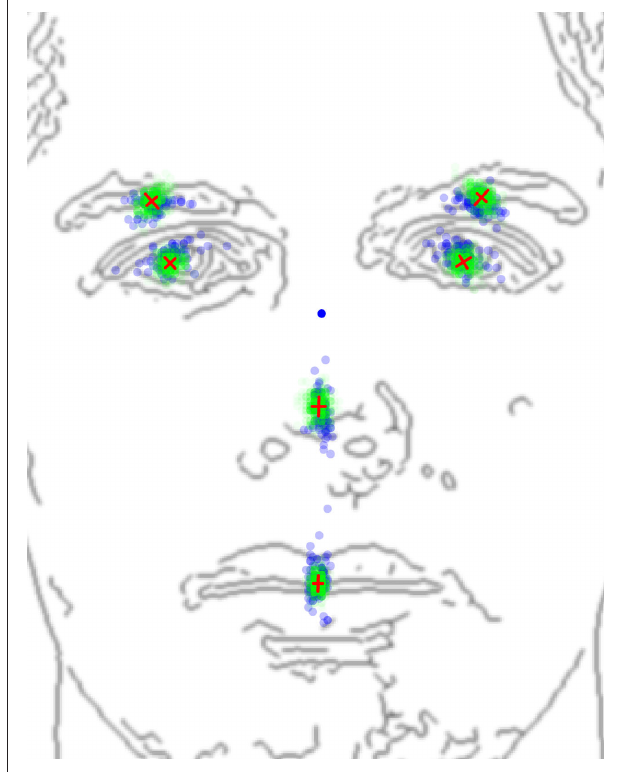
Figure 2 | Distribution of interattribute distances. Distribution of post-alignment attribute positions (green dots) of the 515 annotated faces, with standard-deviation-length eigenvectors (red segments) centered on the distributions, and overlaid to the contours of a face to facilitate the interpretation. The blue dots are the attribute positions of stimuli of 14 previous studies that used distance manipulations (Haig, 1984; Sergent, 1984; Hosie et al., 1988; Rhodes et al., 1993; Tanaka and Sengco, 1997; Leder and Bruce, 1998, 2000; Freire et al., 2000; Barton et al., 2001; Leder et al., 2001; Le Grand et al., 2001; Bhatt et al., 2005; Goffaux et al., 2005; Hayden et al.,